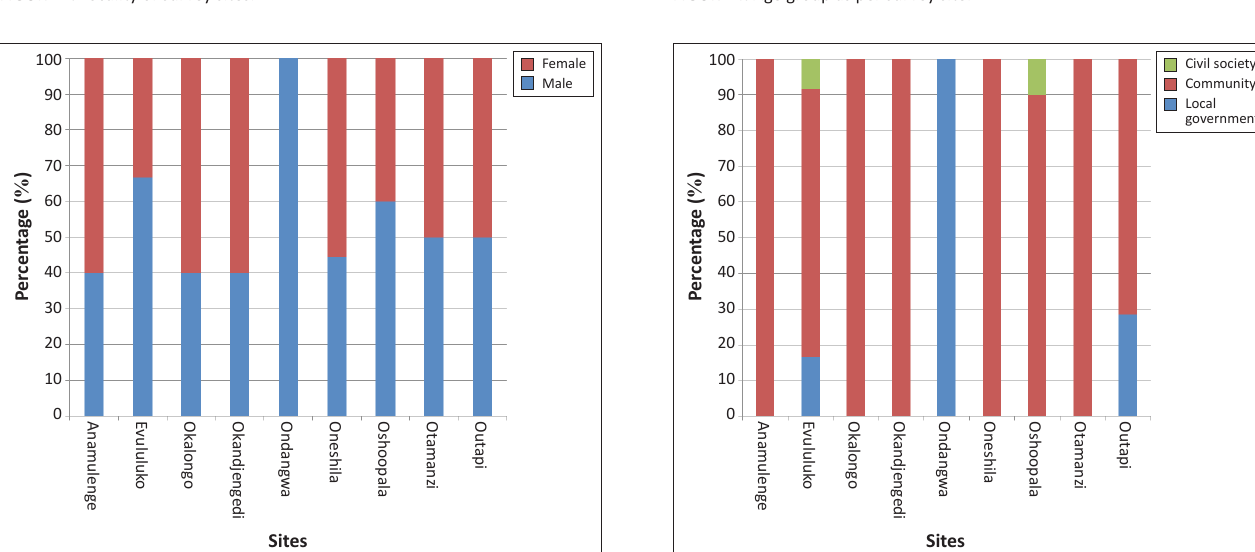
FIGURE 2: Locality of survey sites.